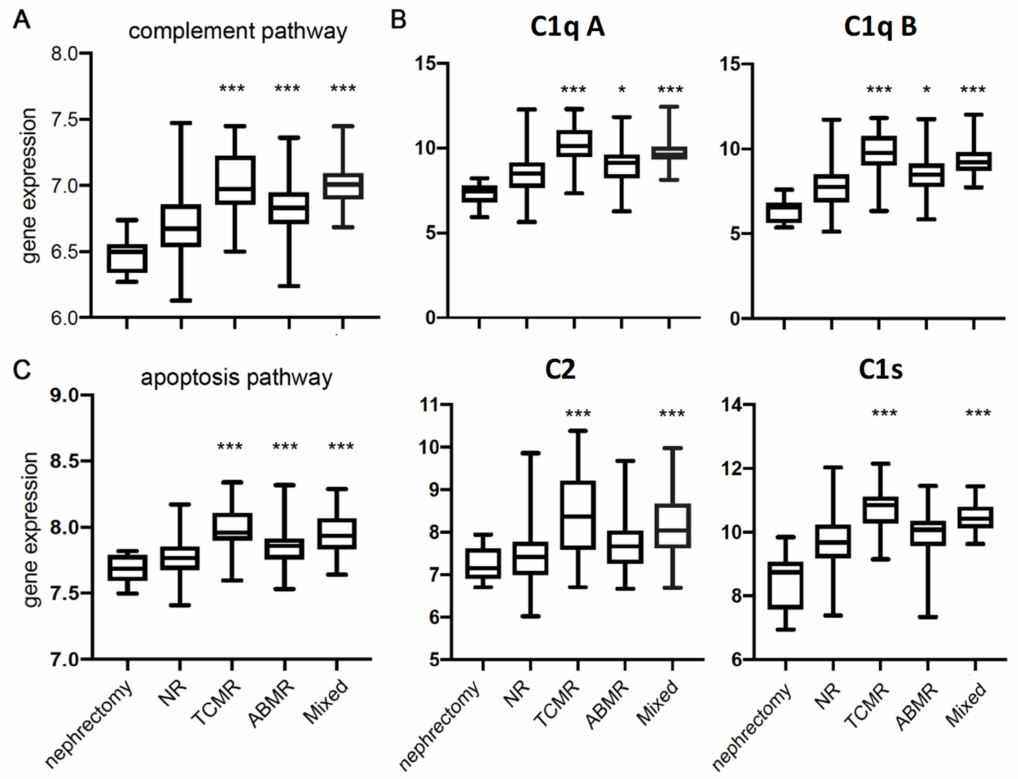
Figure 1. Transcriptome analysis of human kidney transplant biopsies. GSE36059 with n = 411 indication biopsies. ( A , C ) KEGG pathways. Gene expression shows pathway activity (mean of sum of all genes). ( B ) Individual genes of the complement pathway. NR = non-rejection. * indicates p < 0.05 compared to nephrectomy, *** indicates p < 0.001 compared to